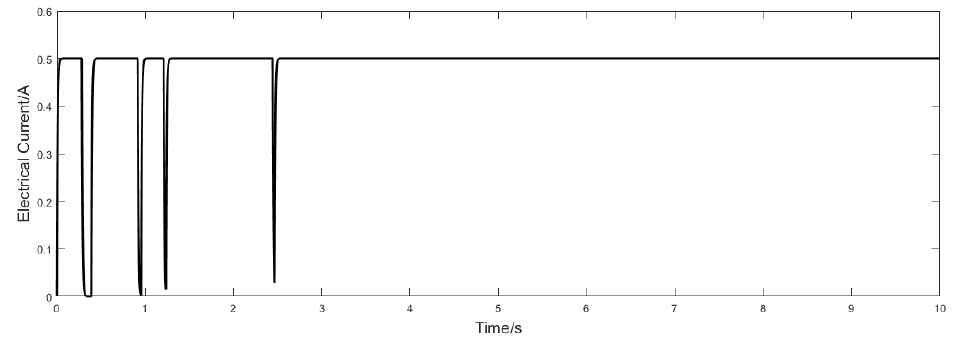
Figure 16. Control signal generated by the PSO/BELBIC control strategy.